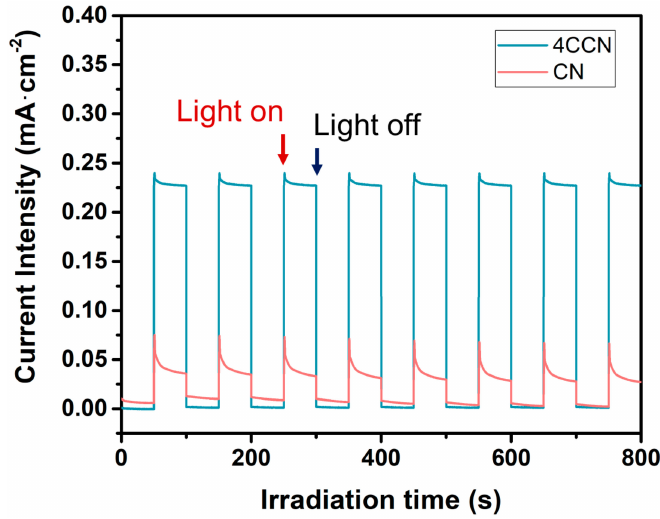
Figure 7. Transient photocurrent responses curves for CN and 4CCN samples under visible light